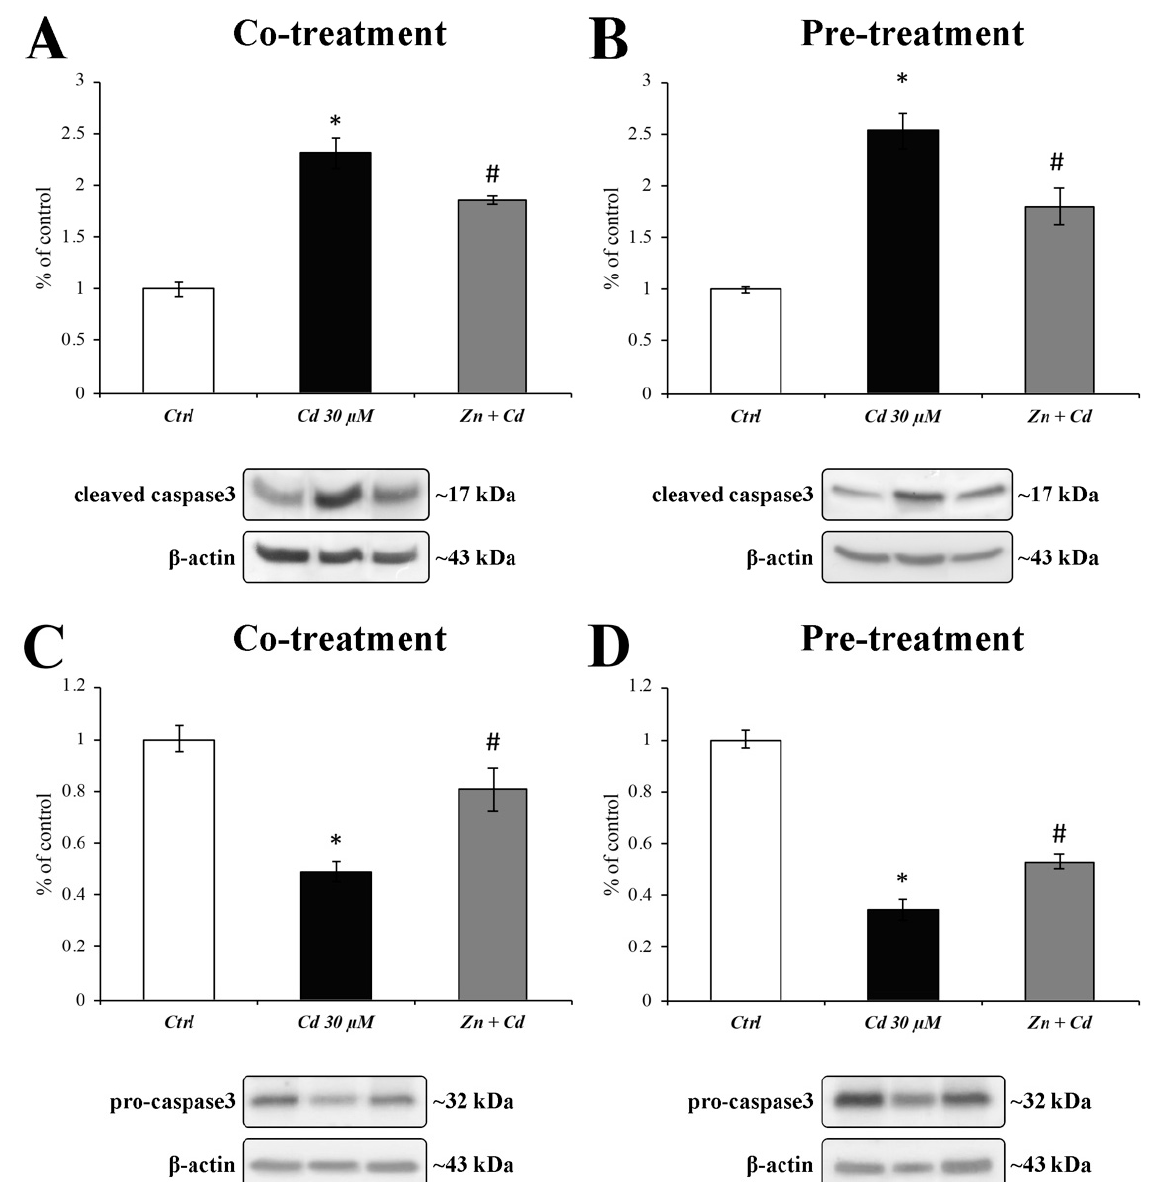
Figure 7. Cleaved and procaspase3 protein expression after CdCl 2 and ZnCl 2 exposure. Histograms show a significant Cd-dependent increase in the cleaved form of caspase3 (( A , B ); black columns), paralleled by a decrease in procaspase3 expression levels (( C , D ); black columns). When RBE4 cells were cotreated ( A , C ) and 24 h pretreated ( B , D ) with ZnCl 2 50 µ M (grey columns), the results revealed a significant decrease in the caspase3 cleaved form ( A , B ) and an associated increase in the procaspase3 form ( C , D ). Results are expressed as mean ± SEM, and control (untreated cells) was arbitrarily taken as 100%. The β -actin housekeeping protein was used as an internal control for protein normalisation. Each experiment point was performed in triplicate, from three different sets of experiments. * p < 0.05 vs. Ctrl; # p < 0.05 vs. Cd treatment. Furthermore, these results were confirmed by the DAPI nuclear counterstaining reported in Figure 8 (middle images), allowing us to identify a Cd-dependent alteration in nuclear morphology, with pyknosis and membrane blebbing typical of apoptotic cell death (Figure 8A,B; white arrowheads in the middle images). This effect was almost reverted by the presence of Zn (right images in Figure 8; both